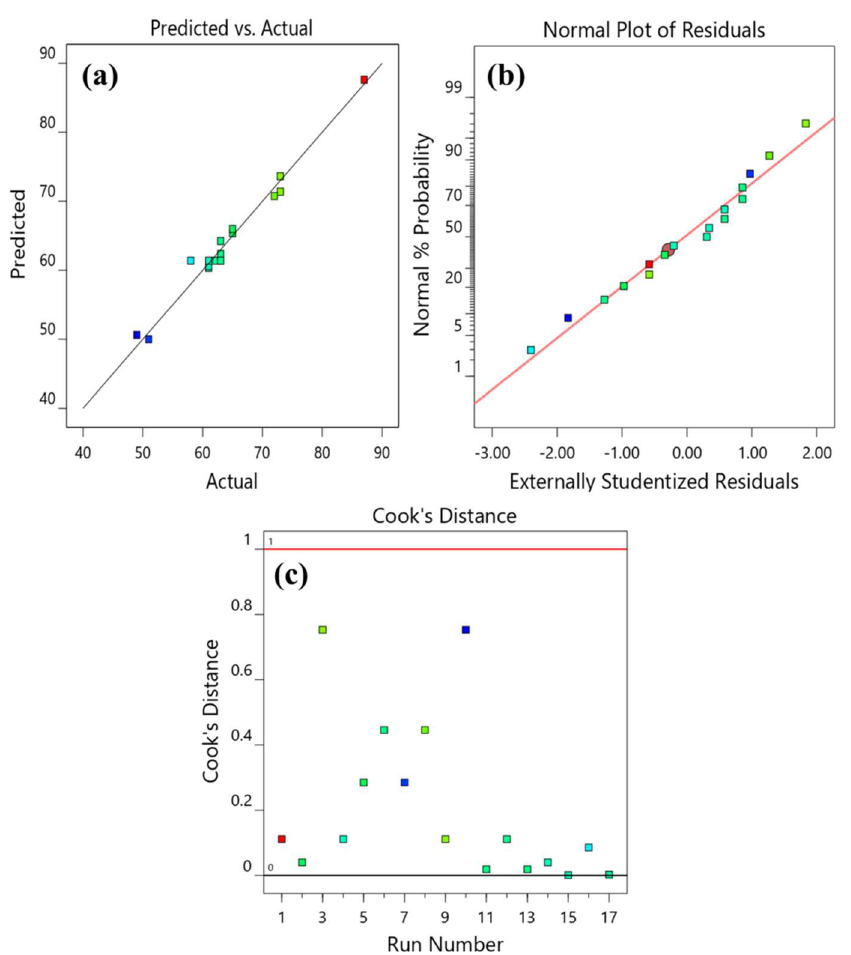
Figure 4. ( a ) Experimental and actual removal, ( b ) normal probability plot of MB (%), and ( c ) Cook’s distance plot.